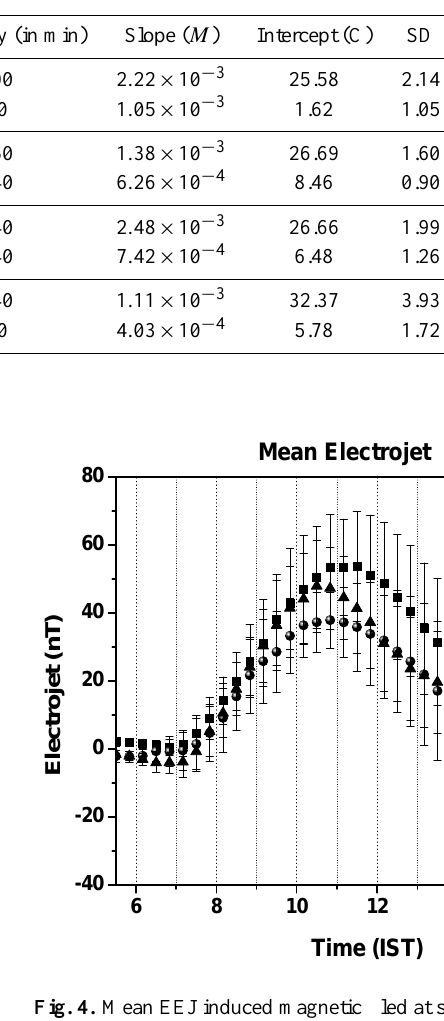
Fig. 4. Mean EEJ induced magnetic filed at surface for the March, July and October months of year